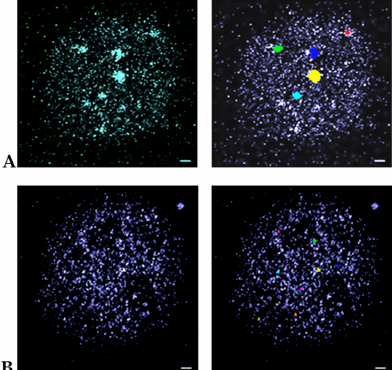
Figure 3. Pointillist SMLM images obtained from the “Orte-Matrix” of MCF-7 cell nuclei. ( A ) γ H2AX labelling; ( B ) MRE11 labelling. The left images are nearest-neighbor illustrations indicating foci by increased intensity. The right images show the clusters as identified by the algorithm applied. These images reveal differently shaped clusters of at least a minimum number of points (for γ H2AX: 110 points; for MRE 11: 60 points) in a given surrounding (for γ H2AX: radius of 200 nm; for MRE11: radius of 100 nm). In general, the MRE11 clusters are considerably smaller than the γ H2Ax-clusters. Scale bar 1 µ m. Note: The different colors of the clusters are only used to better separate them for